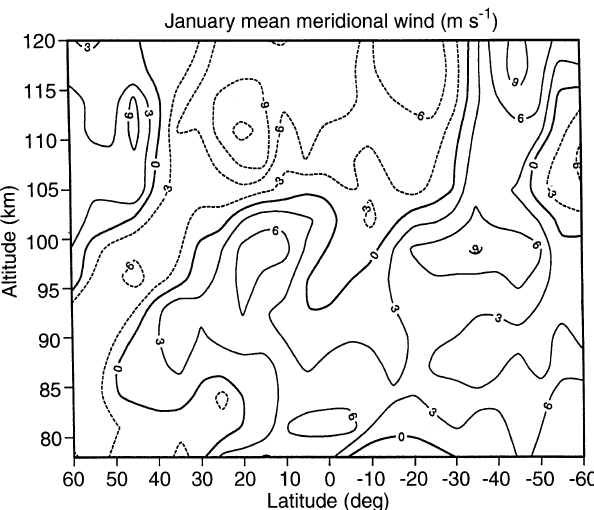
Fig. 5. Latitude-height distribution of the mean meridional wind in January